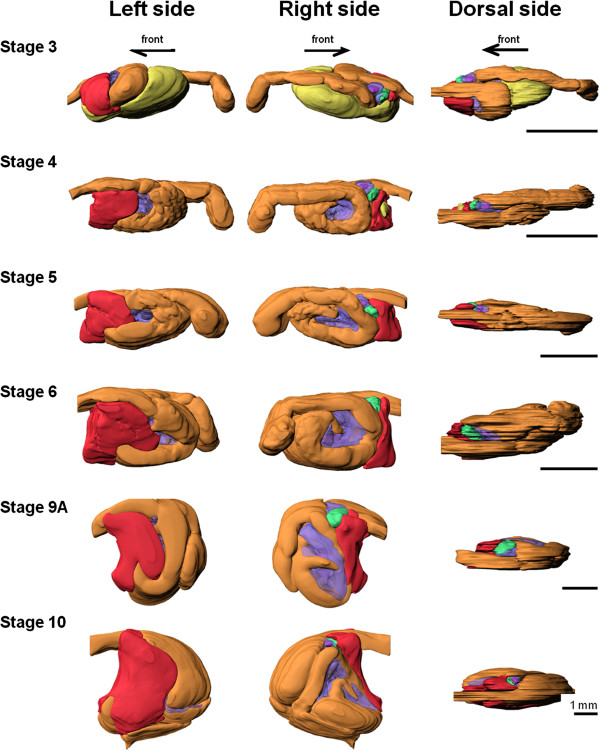
Ontogeny of the digestive organs in Atlantic halibut larvae. 3D models were reconstructed from serial histological sections using Imaris software. The digestive organs are shown from three angles; left, right and dorsal side. Arrows indicate the anterior direction (mouth). Orange outer layer of GI-tract, red liver, green gallbladder, purple pancreas, pink islet of Langerhans, yellow yolk-sac. Transparent colour is used for exocrine pancreas (purple) in order to show islets of Langerhans (pink) and gallbladder (green).